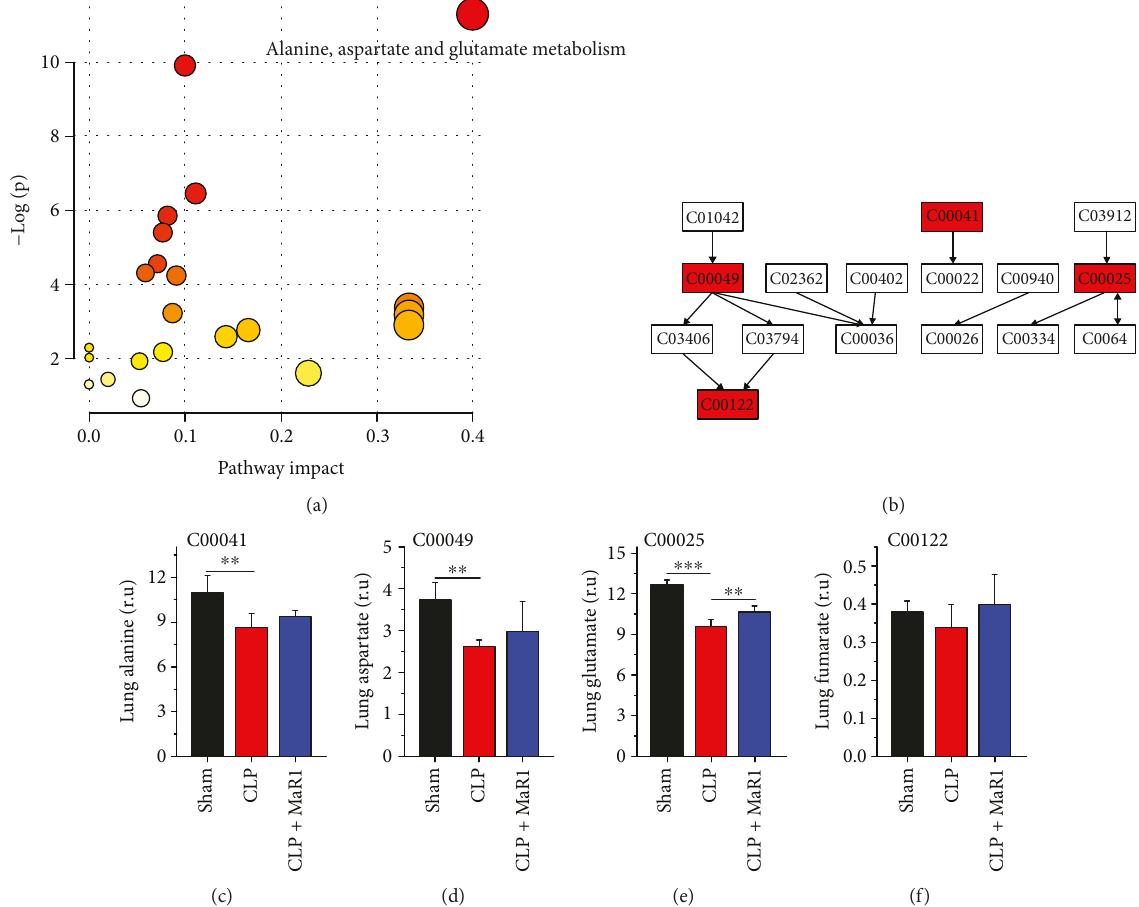
Figure 8: Metabolic pathway analysis in lung of septic mouse treatment with MaR1. Pathway analysis carried out by the pathway topology analysis among three groups (a) and the pathway fl owchart of alanine, aspartate, and glutamate metabolism (b). The key metabolites are shown in (c) ~ (f). ∗∗ P < 0 01 and ∗∗∗ P < 0 001 , n = 6 per